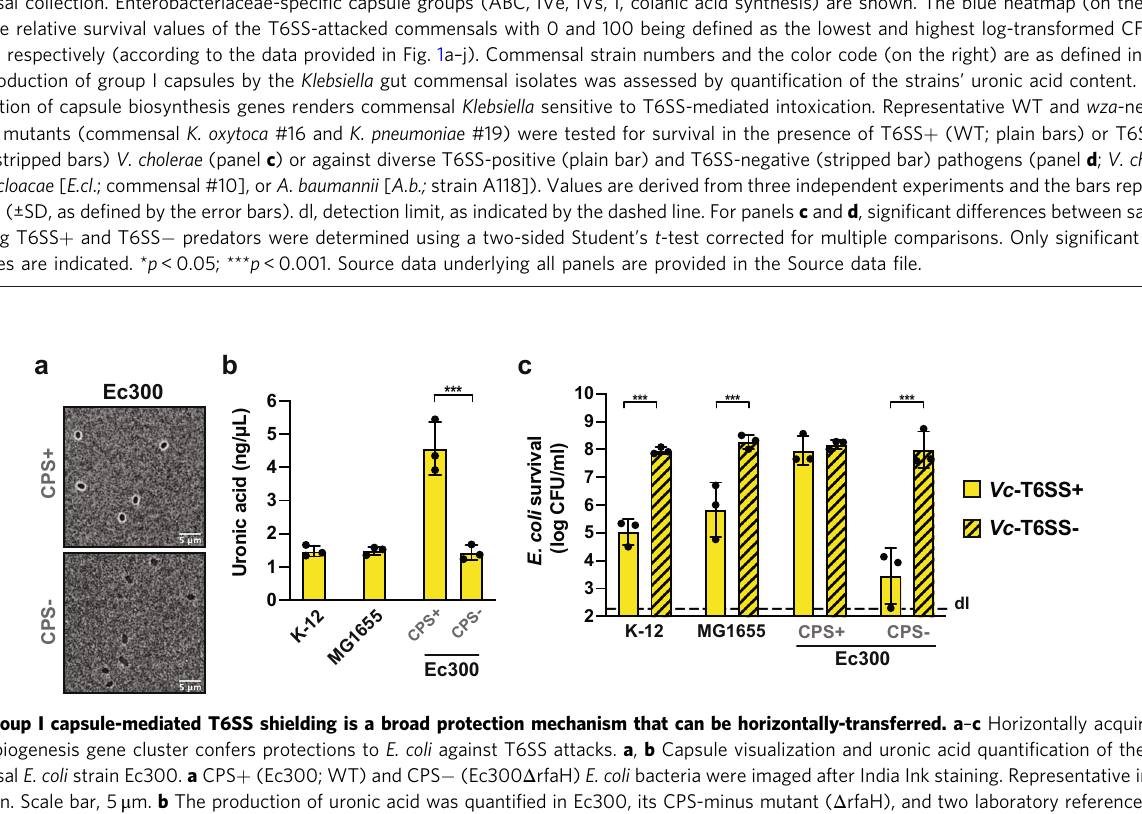
Fig. 4 Group I capsule protect commensal Klebsiella isolates against V. cholerae ’ s T6SS attacks. a In silico identi fi cation of capsular genes in the commensal collection. Enterobacteriaceae-speci fi c capsule groups (ABC, IVe, IVs, I, colanic acid synthesis) are shown. The blue heatmap (on the left) shows the relative survival values of the T6SS-attacked commensals with 0 and 100 being de fi ned as the lowest and highest log-transformed CFU/ml numbers, respectively (according to the data provided in Fig. 1a – j). Commensal strain numbers and the color code (on the right) are as de fi ned in Fig. 1. b The production of group I capsules by the Klebsiella gut commensal isolates was assessed by quanti fi cation of the strains ’ uronic acid content. c , d Deletion of capsule biosynthesis genes renders commensal Klebsiella sensitive to T6SS-mediated intoxication. Representative WT and wza -negative Klebsiella mutants (commensal K. oxytoca #16 and K. pneumoniae #19) were tested for survival in the presence of T6SS + (WT; plain bars) or T6SS −